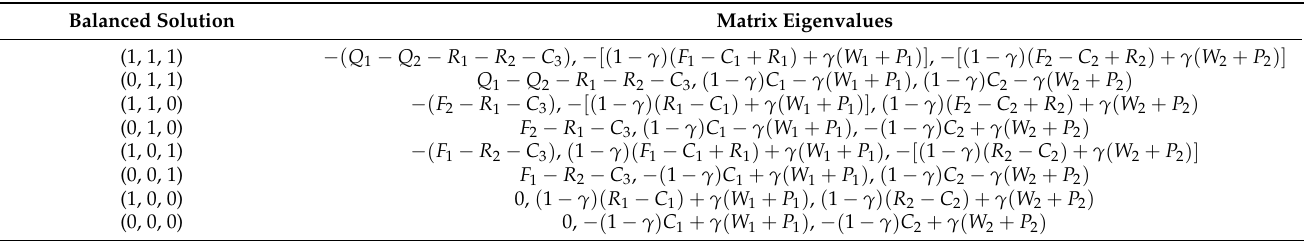
Table 3. Eigenvalues of the equilibrium solution.